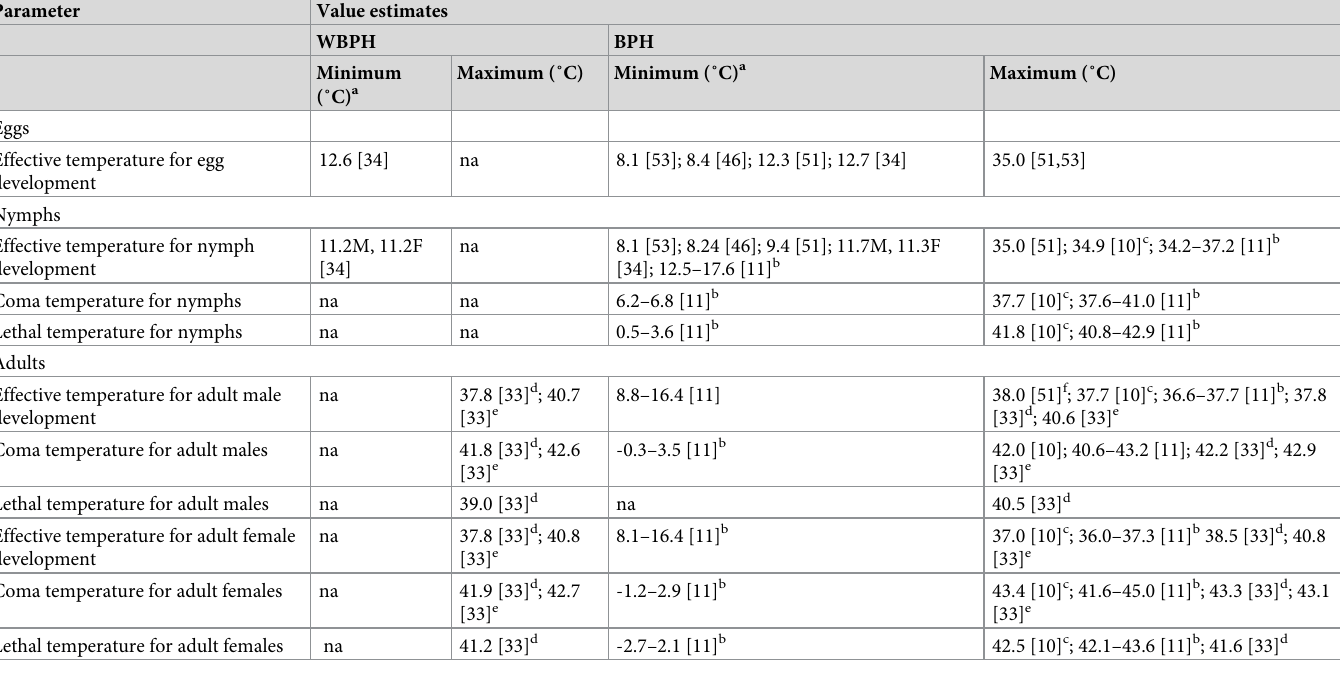
Table 1. Key temperature extremes for WBPH and BPH based on published